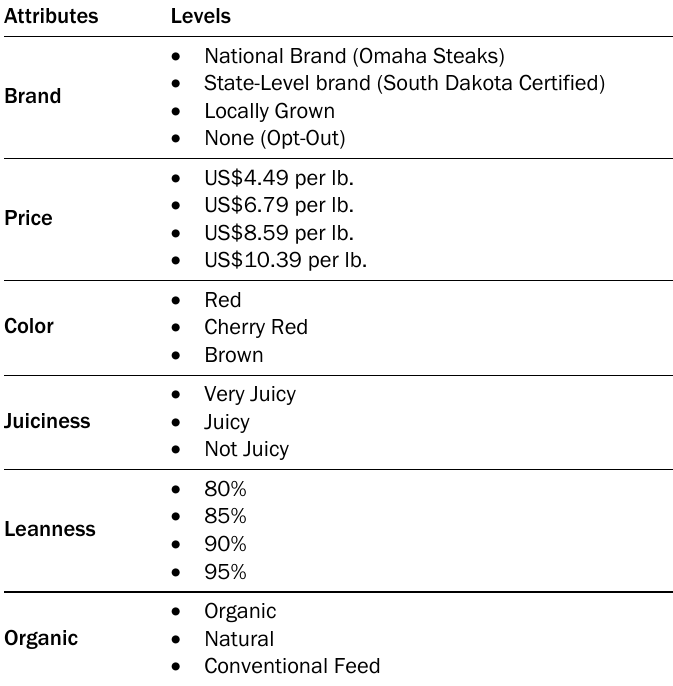
Table 1. Summary of Selected Product Attributes and Levels Attributes